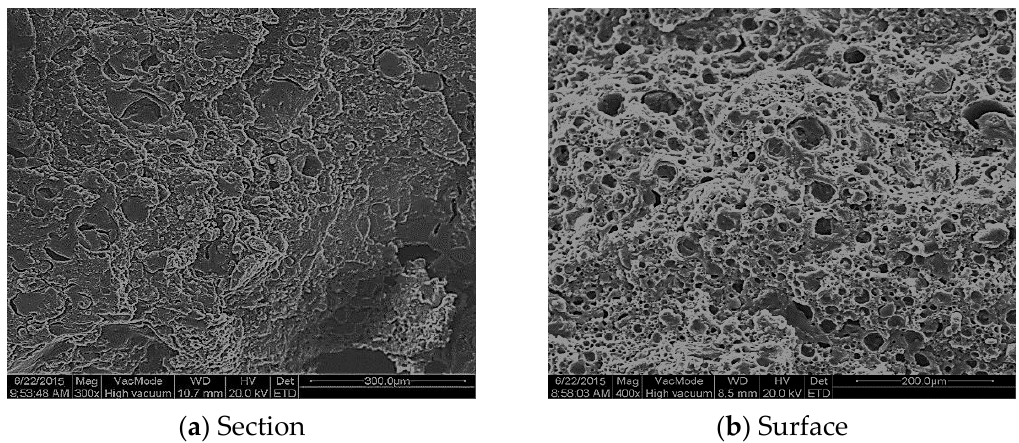
Figure 14. Micromorphology of HPBFA-cured specimens.